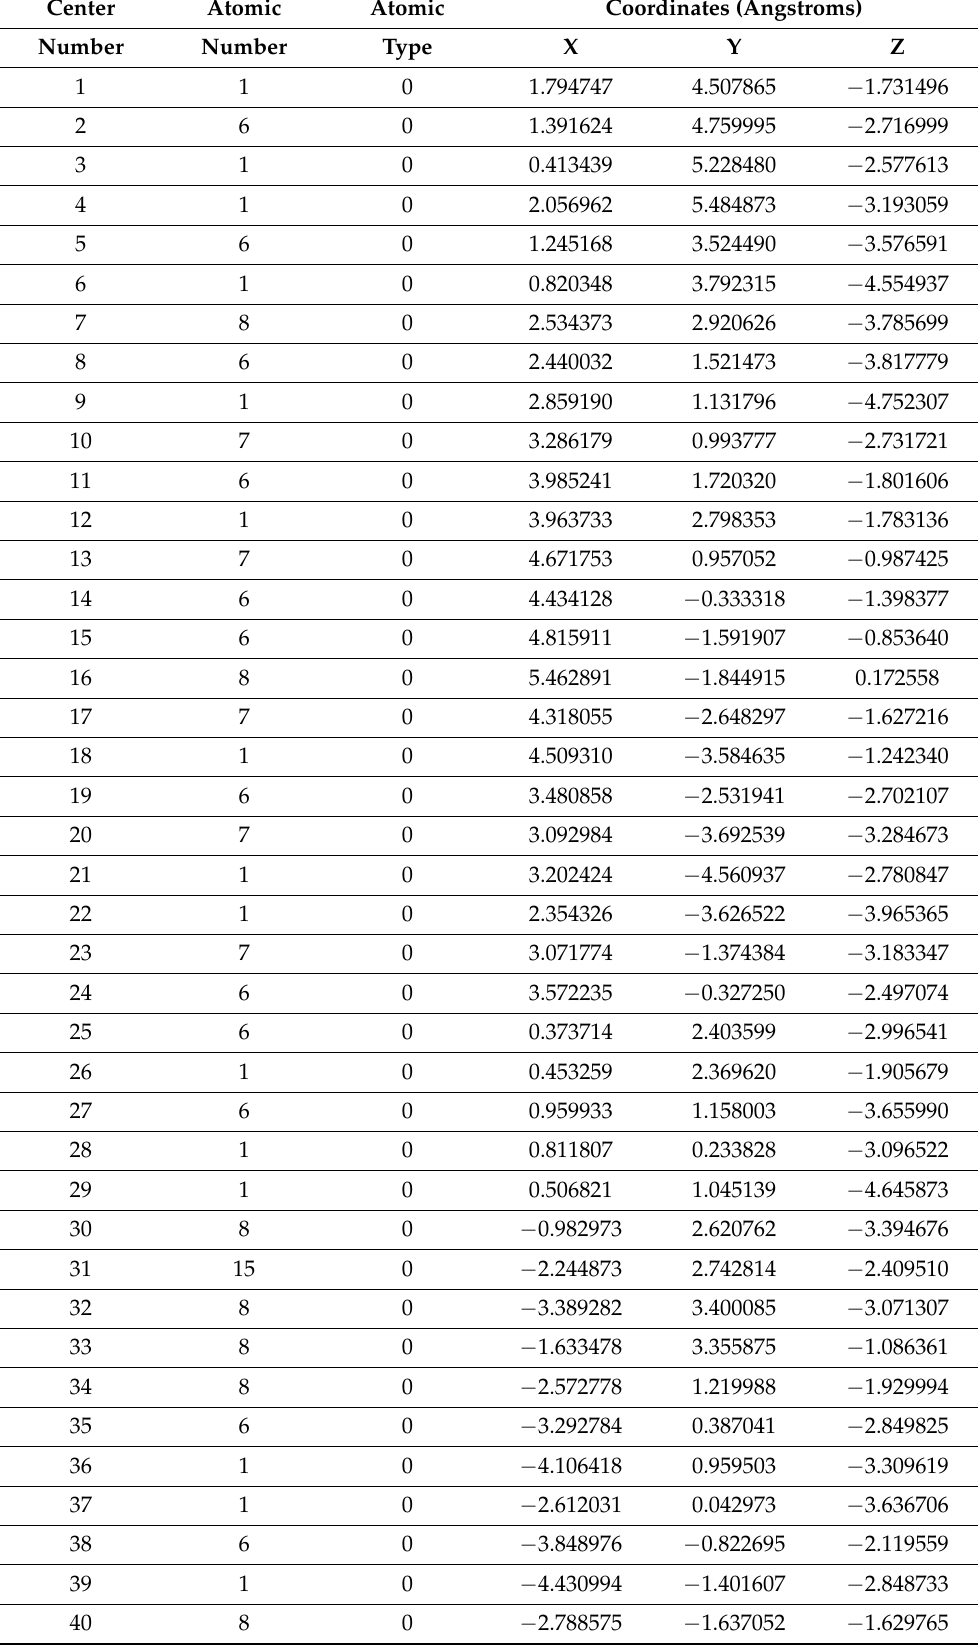
Table A4. Complex LiI 2 with nucleotide triplet